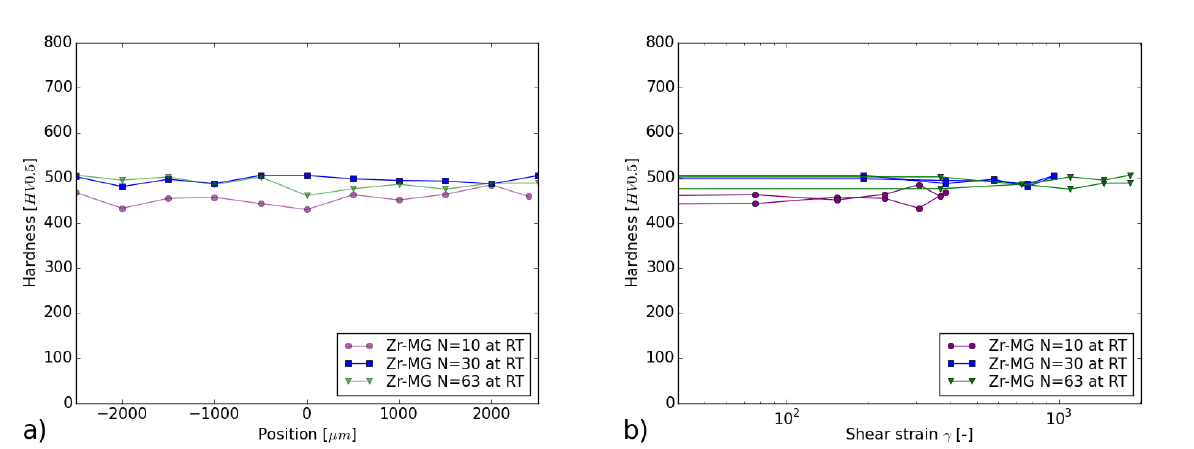
Figure 7. The results of Vickers hardness measurements can be seen. The